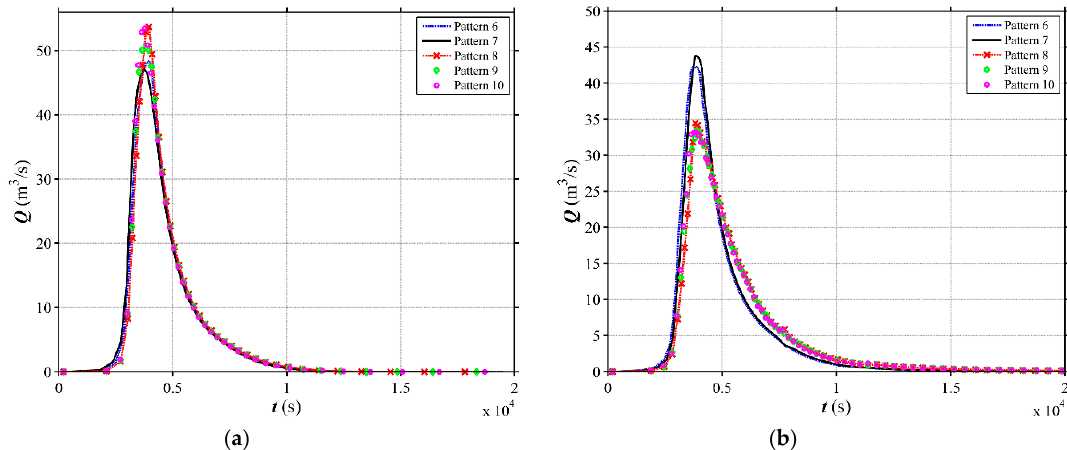
Figure 15. Simulated hydrographs at the outlet for different vegetation cover patterns in the V-shaped catchment under 100-year rainfall event (vegetation cover is 70%). ( a ) i 1 = 0.01, i 2 = 0.58; ( b ) i 1 = 0.08, i 2 = 0.58.